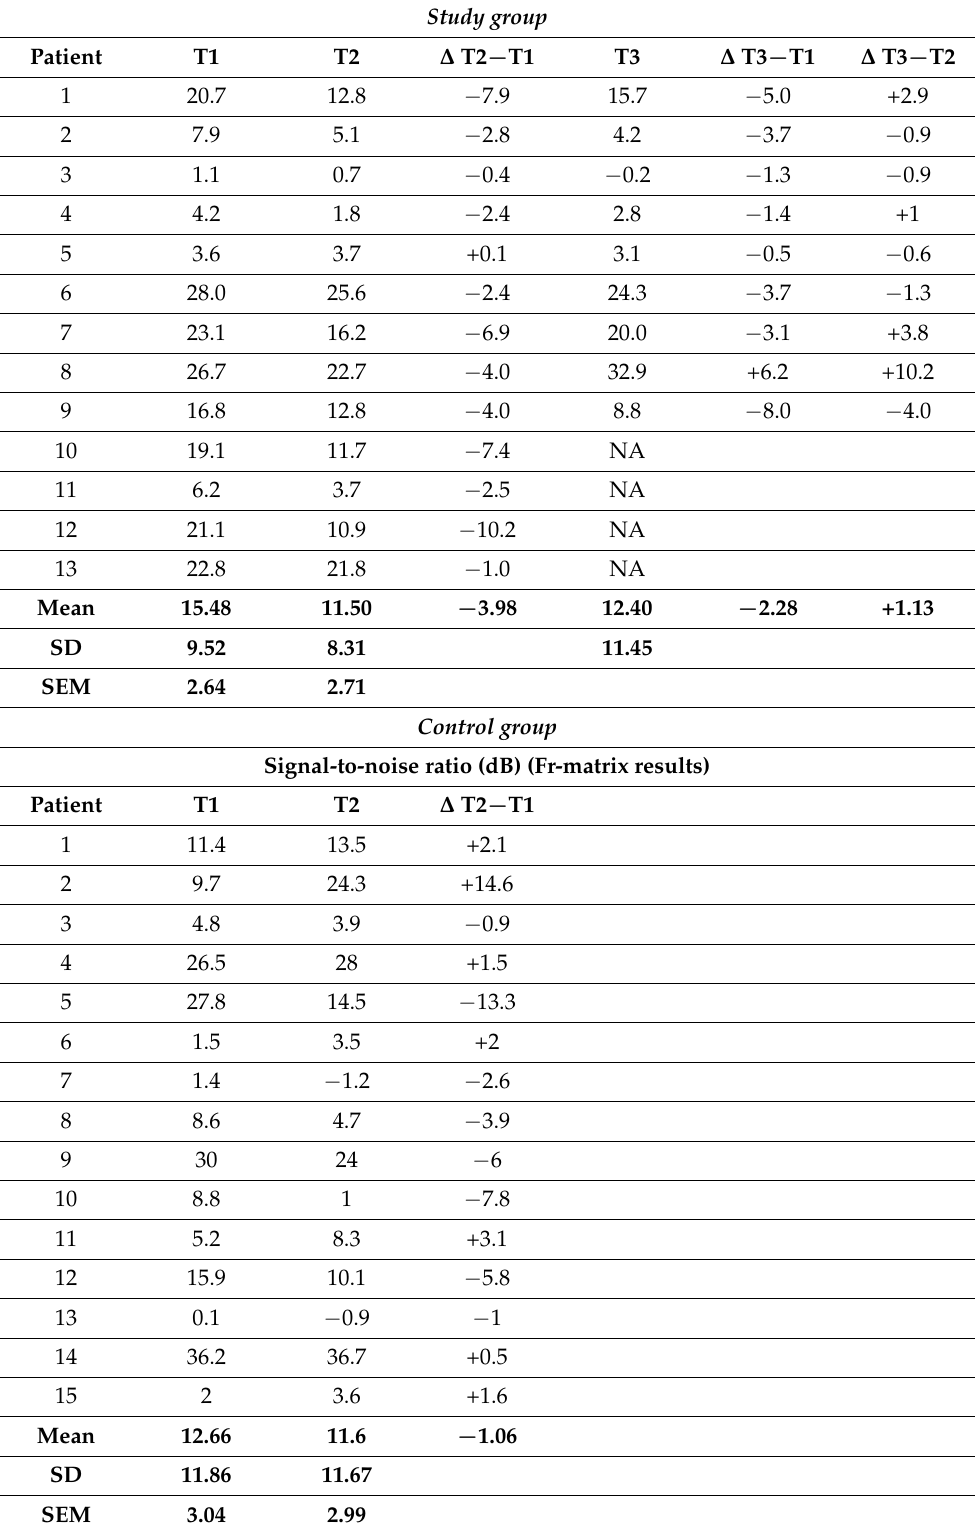
Table 2. Individual and mean signal-to-noise ratio (SNR) results from Fr-matrix for the study and control groups at enrollment (T1), at 5 weeks (T2), and, for the study group, 5 weeks post- intervention